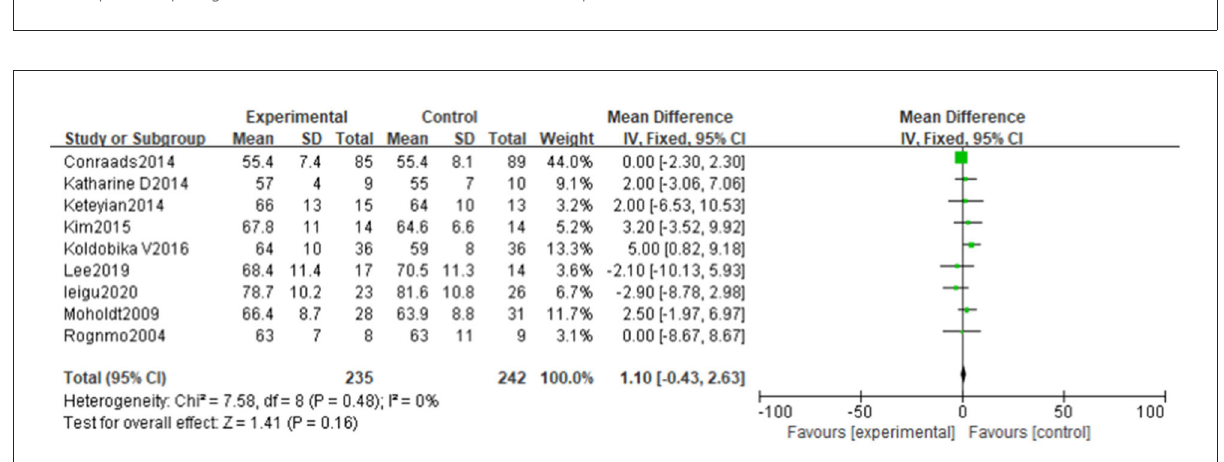
FIGURE7 Forest plot comparing the effects of two exercise modes on RER improvement.